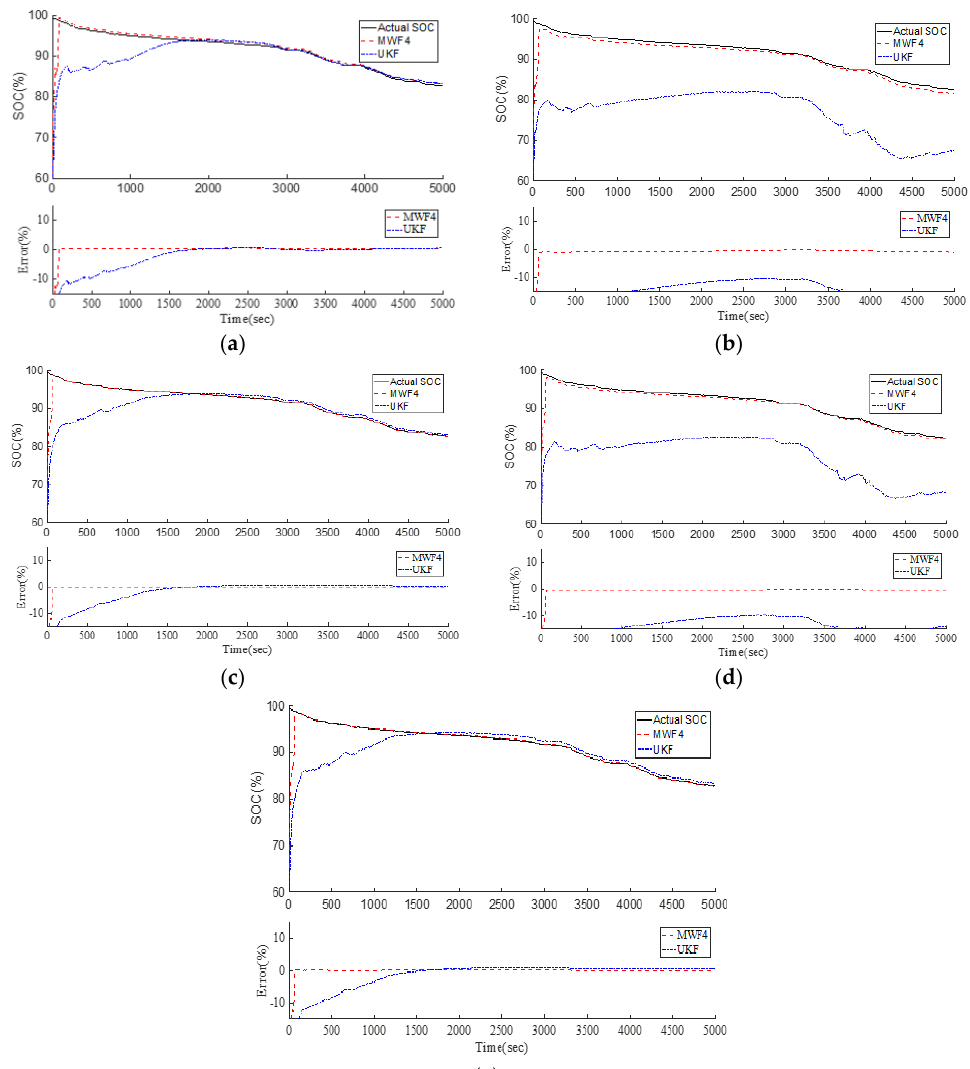
Figure 19. SOC estimation comparison of cells 1 to cell 5 ( a – e ).